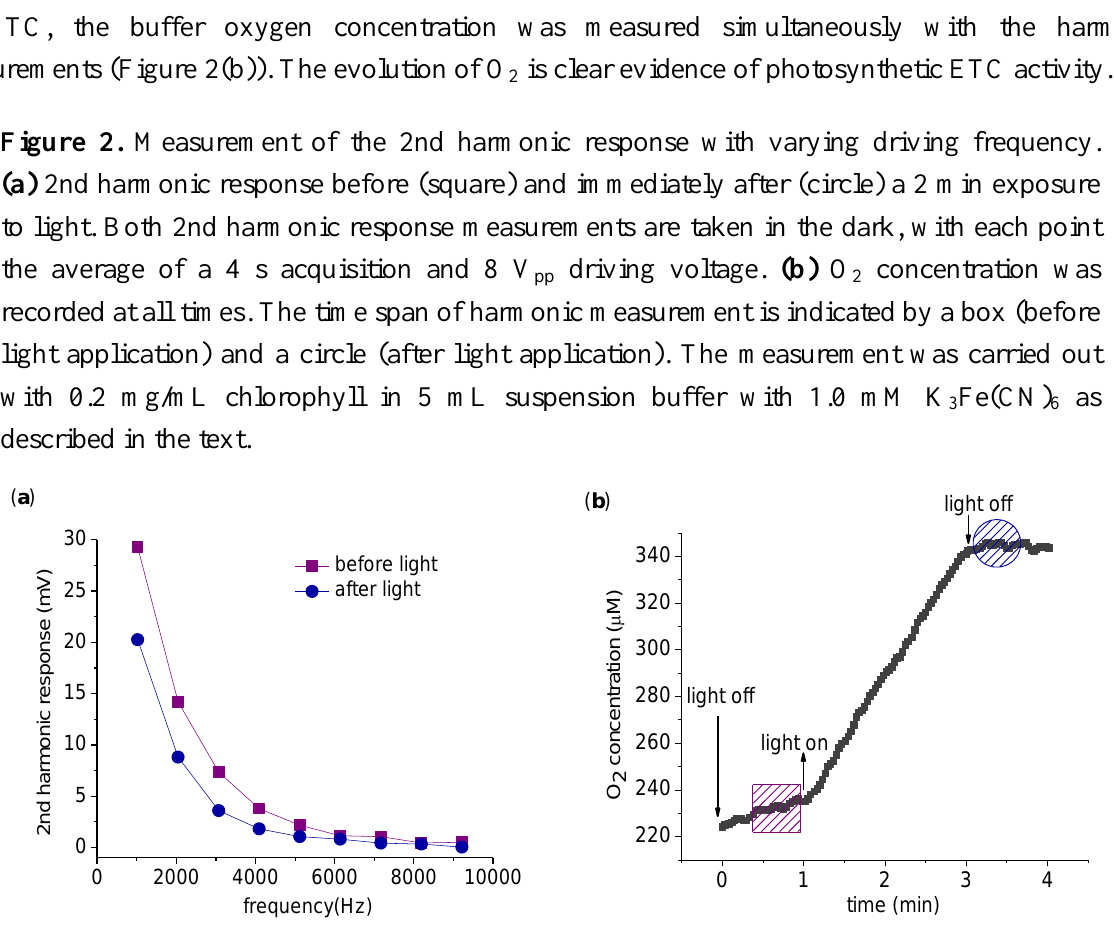
driving voltage. (b) O concentration was pp 2 Fe(CN) as 3 6